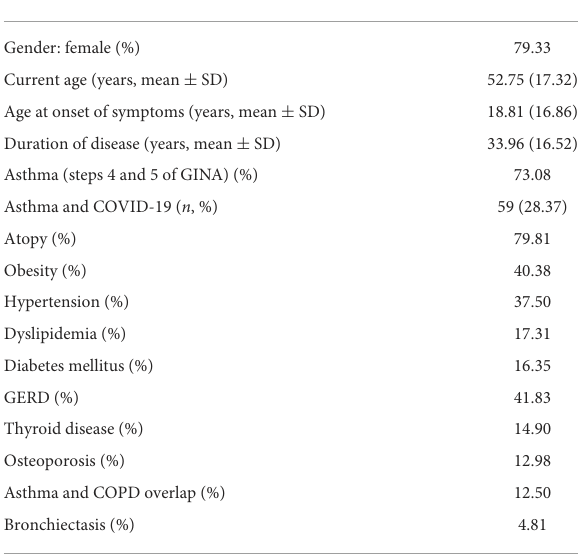
TABLE 2 General characteristics of asthmatic